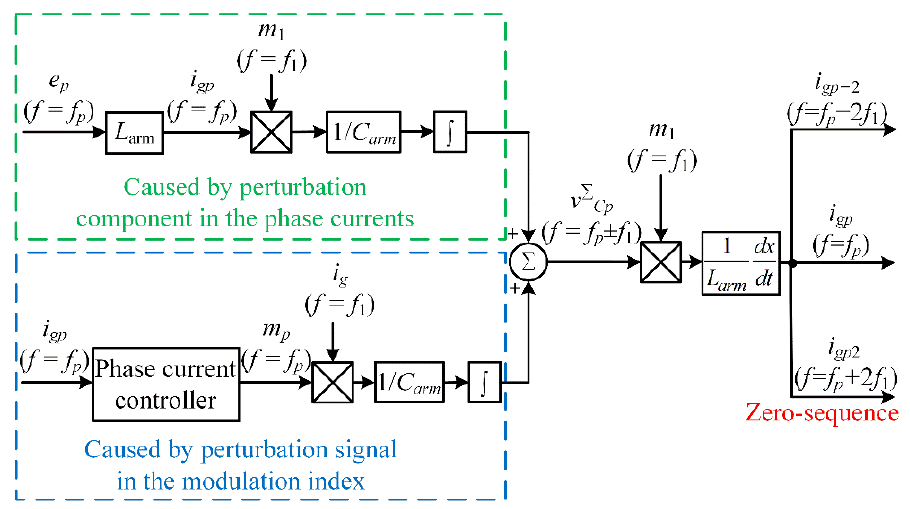
Figure 3. Illustration of the frequency coupling in MMC.